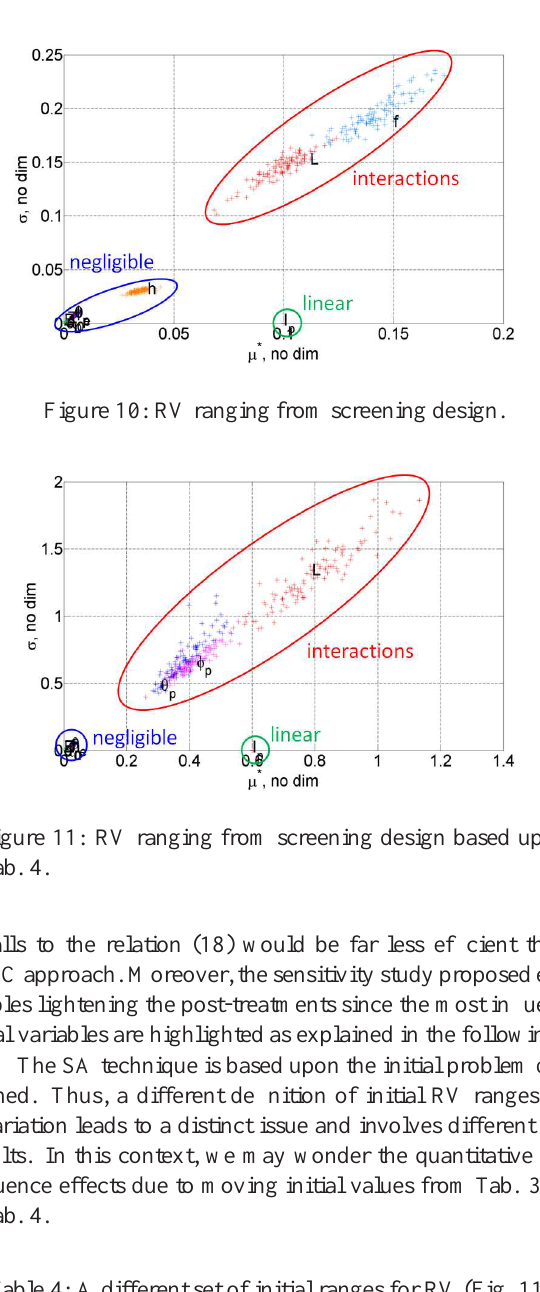
Table 4: A different set of initial ranges for RV (Fig. 11).